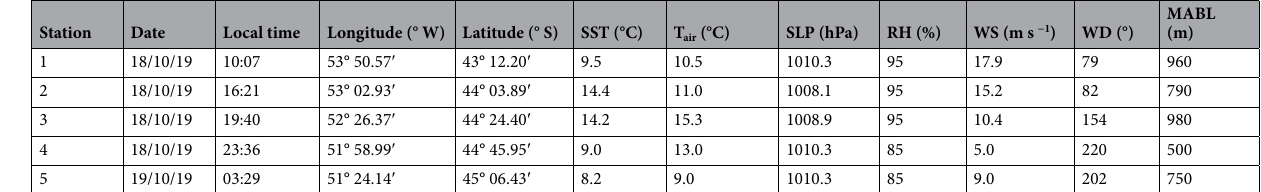
5 °C between the WCE and its border and of roughly 7 °C across the strong thermal front, similar to the ones seen previously at the BMC front 2,3 . This marked gradient is responsible for modifying the surrounding oceanic environment where this WCE is situated as we later demonstrate. The WCE had its center located at 44°S and 52°W with a mean radius of 95 km when observed. These characteristics are similar to a previous WCE analyzed in this region 28 . The structure extended north–south for 1.8° and east–west for 2°, as estimated using the SLA from satellite altimetry (Fig. 1d). A direct relationship between SST, SLA, and the geostrophic currents derived from SLA can be seen in Fig. 1c. The WCE exhibited translational velocities reaching 1 m s −1 while the CCE velocities were less than 0.5 m s −1 (Fig. 1c). The lifecycle of a WCE detached from the Brazil Current can last for months with estimated translational velocities ranging from 5.8 to 7.8 km day −1 and, instead of just merging into surround waters by mixing or diffusion, can be re-assimilated by the parent current 21 . In our case, the eddy life cycle lasted 86 days (7 September 2019 to 1 December 2019) after which it was re-assimilated by the Brazil Current. The WCE also imprinted a profound signal in the chlorophyll-a surface concentration field. The typical mean Chl-a values over the BC (MC) ranged from 0.015 to 0.5 (0.2 to 0.5) mg m -3 during September and Octo- ber 2019 15 . In Fig. 1b,d it is evident that SST and Chl-a values at the WCE center are those typically found in BC waters. This confirms that this eddy was decoupled from the BC and transported its characteristics along its trajectory, a mechanism 44 called eddy trapping. Furthermore, at the WCE periphery (where colder waters were located) we found higher Chl-a values, reaching 1.5 mg m -3 . Similar Chl-a patterns in anticyclonic eddies in, and to the north of, the Southern Antarctic Circumpolar Current Front were previously observed 45 . It has also been observed that submesoscale density fronts (horizontal scale < 10 km) are commonly generated at the periphery of mesoscale eddies 44,46,47 . These submesoscale fronts are characterized by strong vertical ageostrophic circulation 48,49 , with upwelling rates reaching 10 m day −1 50–52 . Therefore, these regions are potentially an efficient route for vertical transport of nutrients 53 . Several studies based upon ocean color data support this idea, reporting high Chl-a surface concentration close to the periphery of eddies 45,47,54 , as also seen in our Fig. 1d. In our case, the low Chl-a concentration in the WCE core may be due to eddy trapping during its formation, while the high Chl-a concentration at the borders might be explained by the action of submesoscale processes (Fig. 1d). Another region with high Chl-a concentration is located northeastward of the WCE, coinciding with the SST front location (Fig. 1b). Due to its anticyclonic circulation and consequent eddy-induced Ekman pumping, there is mass convergence inside the WCE that results in a deepening of the thermocline where the eddy is located (Fig. 2). An increase in Chl-a concentration (Fig. 1c) of 1.5 mg m −3 up to 4 mg m −3 at very localized spots is seen in the regions where the greatest SST gradients are located between the WCE and the cold waters around it (e.g. 44°S and 55°W). The same happens where the CCE is located (Fig. 1a), with a consequent resurgence of nutrient-rich colder waters. The high Chl-a con- centration seen at the WCE periphery coincides with the climatological October-December Chl-a concentration 55 of 1.5 mg m −3 associated with the Patagonian Shelf Large Marine Ecosystem (PSLME), one of the most productive and complex marine regions in the Southern Hemisphere 56 and located slightly to the west of the WCE. The vertical structure of our WCE clearly reveals a mixed layer depth of 426 m with temperatures ranging from 14 °C to 14.2 °C (red line in Fig. 2a). A well-stablished thermocline occurs below it, with temperatures ranging from 13.9 °C at 430 m to 5 °C at 760 m, as shown in Fig. 2a. Both indicate that this is a barotropic and well mixed temperature region in the ocean. The opposite is seen when moving from the eddy center towards its borders, where colder waters are present. This is seen mainly in the CCE (profile 4 and 5 in Fig. 2a). Those